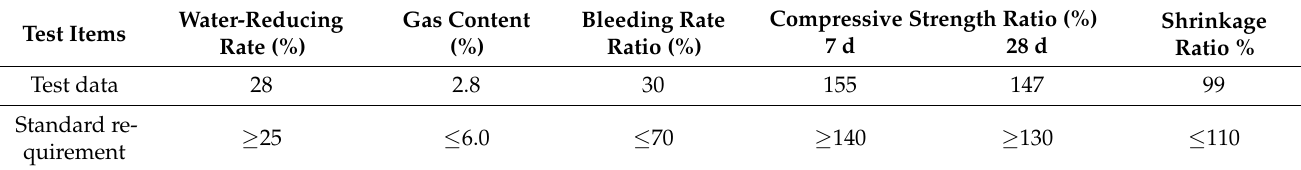
Table 4. Chemical compositions of OPC, slag powder, fly ash, silica fume, and stone powder.